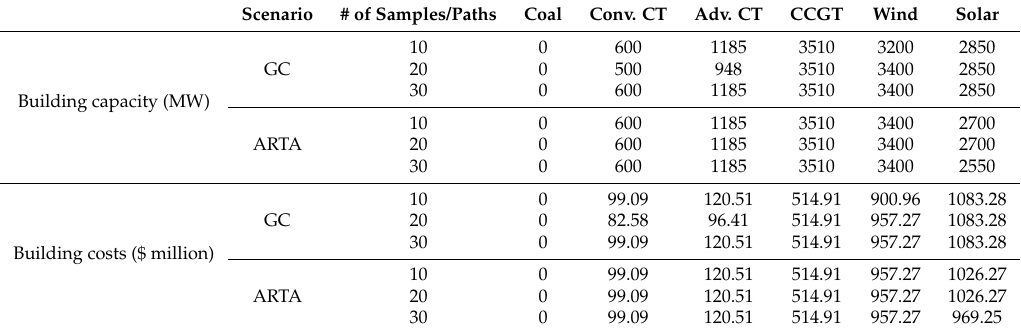
Table 5. Optimal Building Capacity & Costs